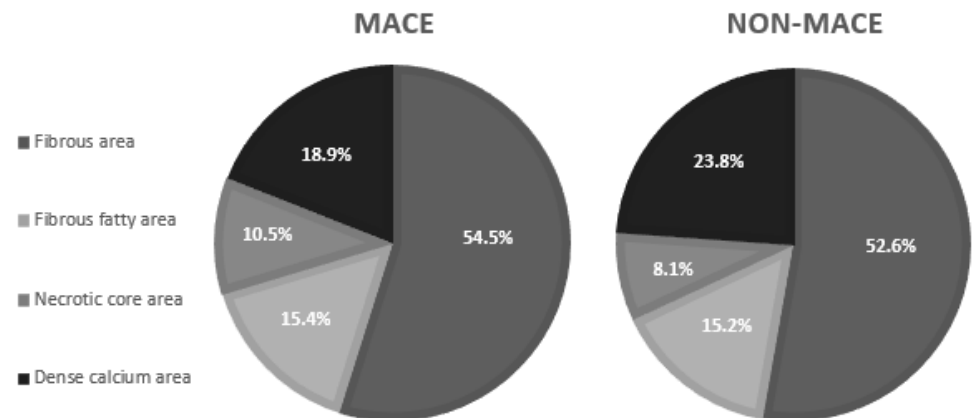
Figure 1. Maximal obstruction site cross-section plaque consistency analysis in MACE and non- MACE groups.